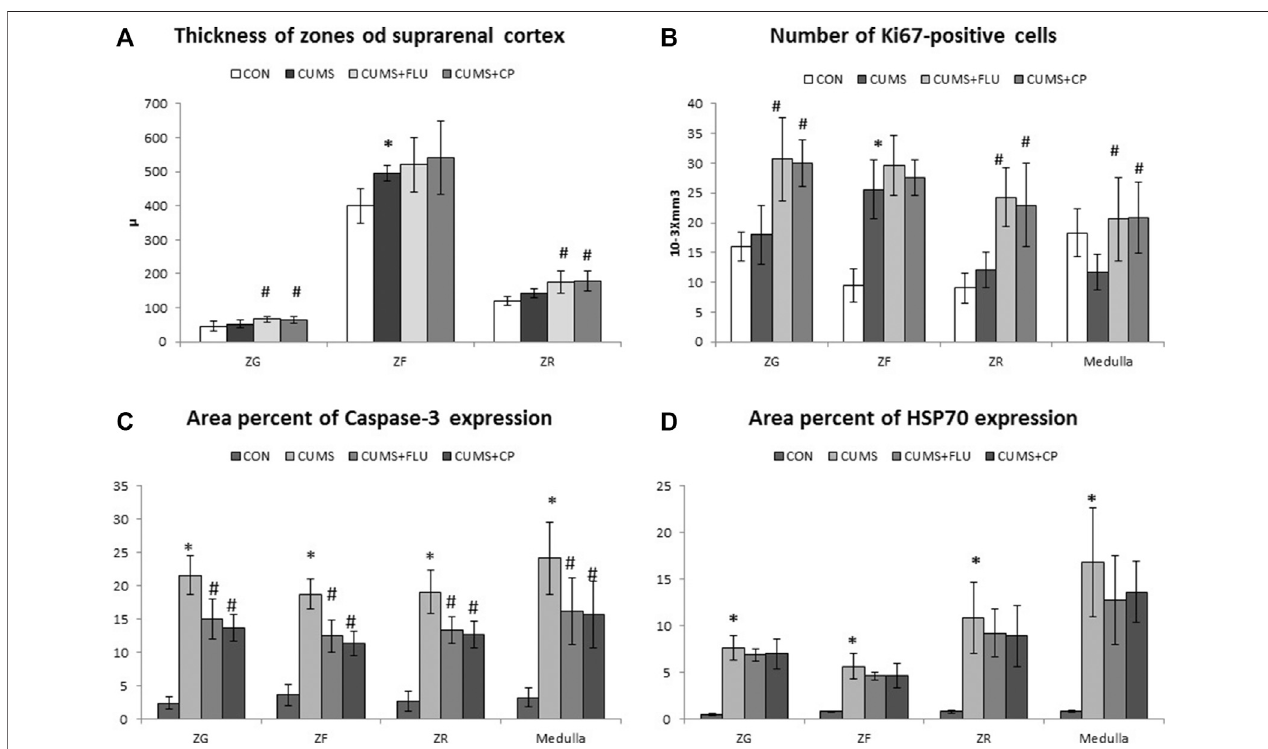
FIGURE5| Thicknessofthesuprarenalcorticalzones (A) ,Immuno-expressionofKi67 (B) ,caspase-3 (C) ,andHSP70 (D) inthestudiedgroups.Dataareanalyzed usingmixed-modeltwo-wayANOVAbasedontheBonferroniposthoctest.Resultsareexpressedasmean ± SD( n (cid:1) 10),dF (cid:1) 36.Resultsareexpressedasmean ± SD ( n (cid:1) 10). A p value < 0.05 was considered signi fi cant. * signi fi cance versus the control group (CON), # signi fi cance versus the chronic unpredictable mild stress (CUMS) group. ZG: zona glomerulosa, ZF: zona fasciculata, ZR: zona reticularis. CON: control, CUMS: chronic unpredictable mild stress, Flu: fl uoxetine, CP: Cucurbita pepo